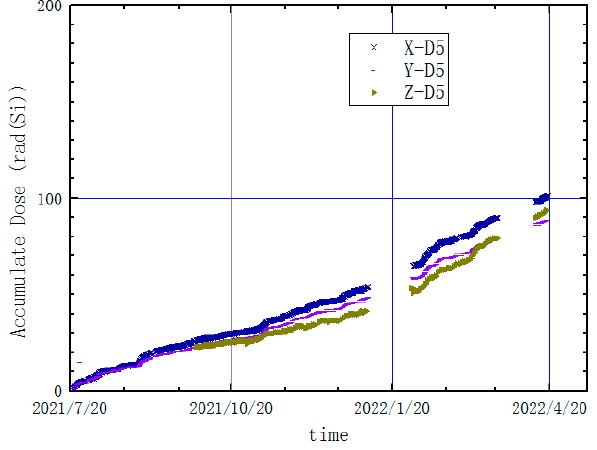
Figure 12. Cumulative dose results of the three dose detectors at monitoring point D5.